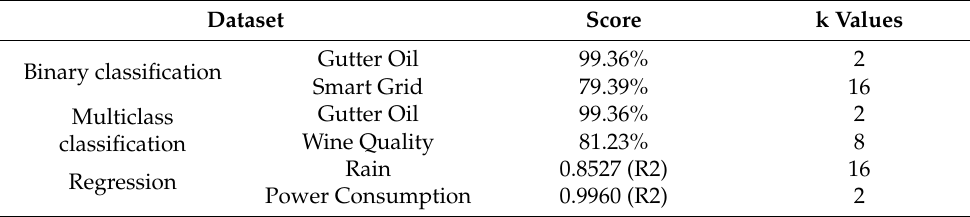
Table 11. The highest-scoring parameters of k-NN obtained in different datasets.